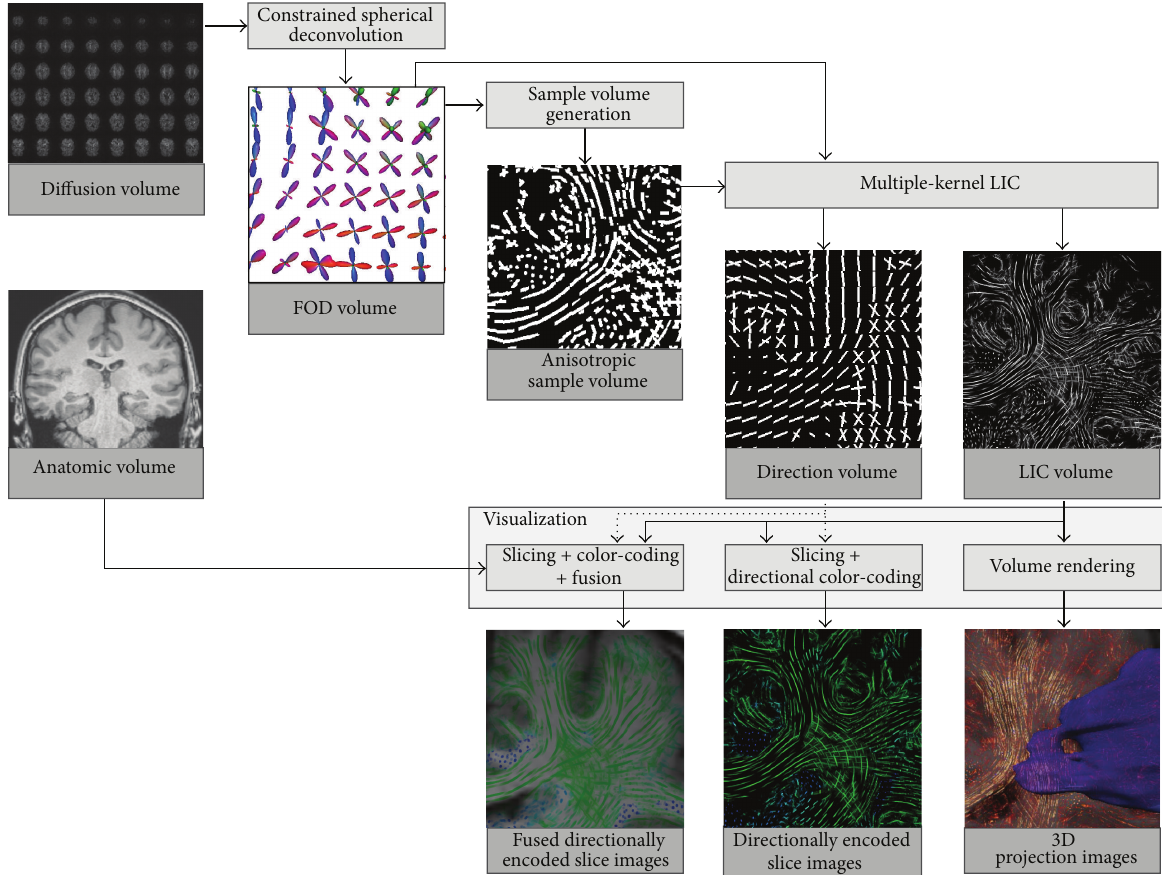
Figure 1: Overview of the most important steps and data elements of the overall